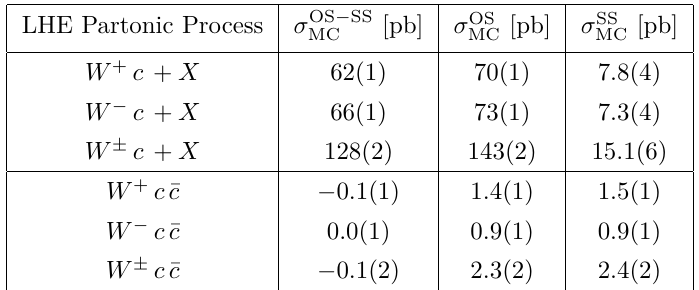
Table 6 . PowHel + PYTHIA8 predictions for the OS - SS, OS and SS inclusive fiducial cross-sections for W ± + D ∗ (2010) -meson production and their sum, with cuts according to the analysis of ref. [22], already considered in section 3.1. Parton shower, hadronization, MPI and beam remnant effects are accounted for using the Monash PYTHIA8 tune. The first three lines are obtained from the use of our full W + ¯ c and W − c event samples, whereas in the last three lines the hadron-level contributions due to W + ¯ c and W − c LHE events including a c ¯ c pair already at the first radiation emission level (case 1 discussed in the text) are singled out. Predictions in the first column, first three lines, correspond to the integration over lepton rapidity of the central predictions shown in the three panels of figure 3, obtained using the ABMP16 PDF set. The quoted uncertainties account for the degree of statistical accuracy of the LHE files used for this study, containing a few million